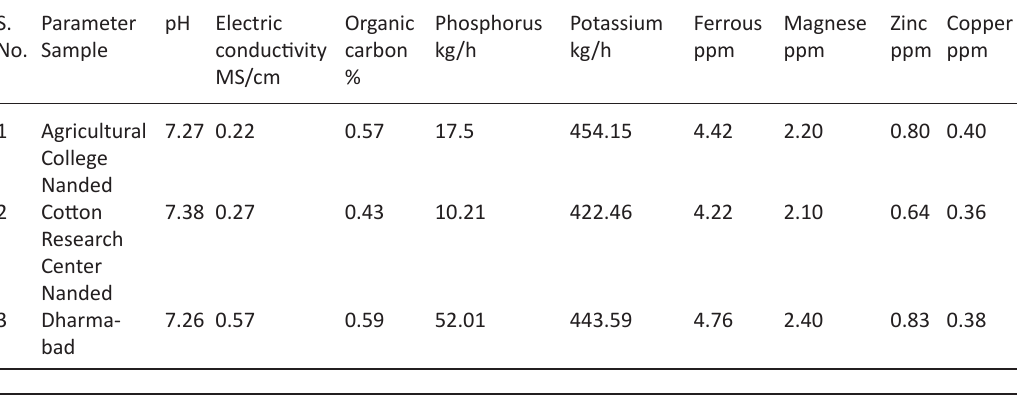
Table 1. Physico chemical analysis of soil samples